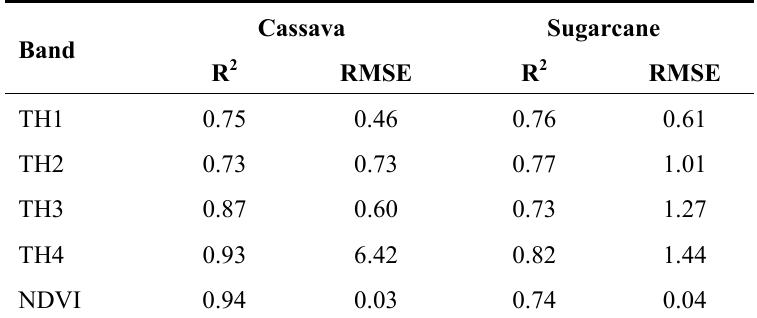
Table 6. Statistics linear regressions between THEOS and Landsat 5 TM surface reflectances for cassava and sugarcane (95% confidence level).